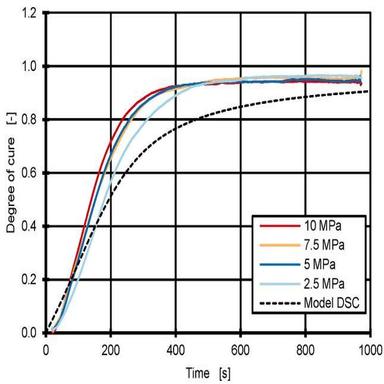
DOC for the isothermal cure under different pressure loads based on RPCSA measurements.